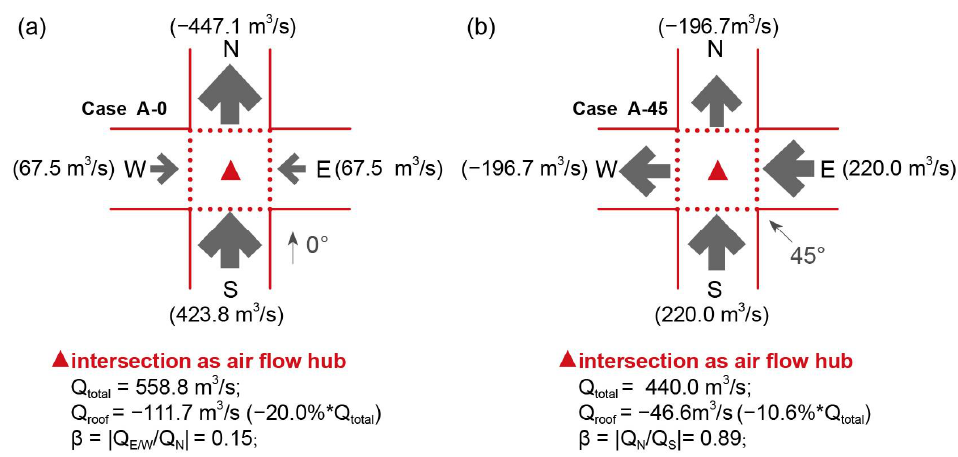
Figure 6. Volumetric flow rate for the intersection and its interfaces in Cases ( a ) A-0 and ( b ) A-45. Positive value indicates inflow; negative value indicates outflow. The factor β refers to the minimum ratio of flow rate between different adjacent street segments.